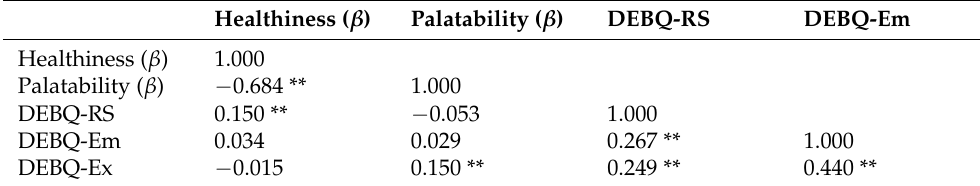
Table 3. The results of correlation analysis between DEBQ and choice to eat. Healthiness ( β ) Palatability ( β )